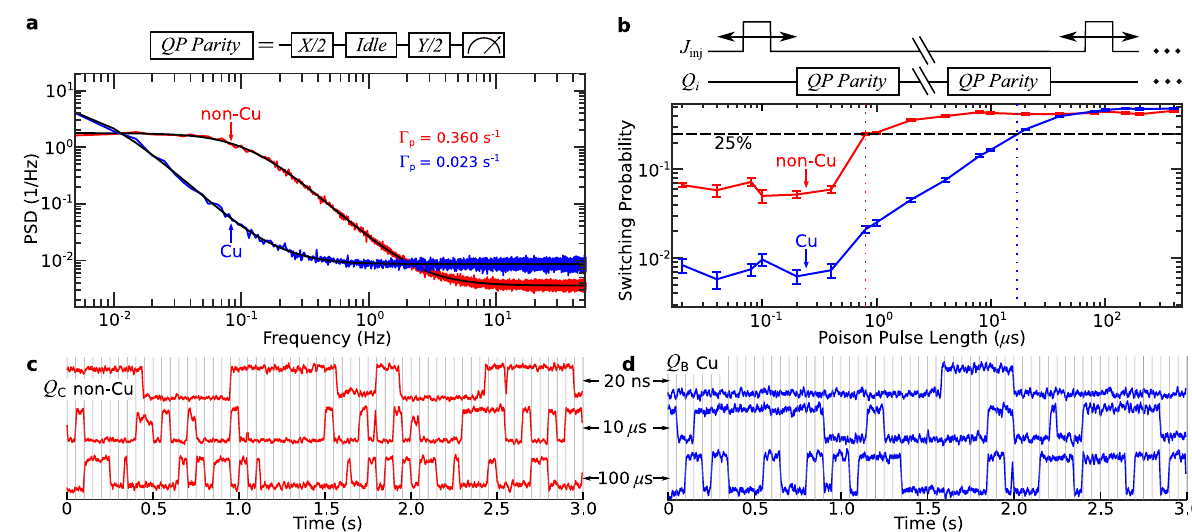
Fig.3|MeasurementofQPparityswitching.a PowerspectraldensityofQPparity switching with no injection pulses for Q A on non-Cu (red) and Cu (blue) chips. b Measured probability of parity switch per injection pulse vs. pulse duration for non-Cu and Cu chips; dotted/dashed lines indicate pulse lengths corresponding to 25% switching probability. Error bars computed from standard Poisson counting